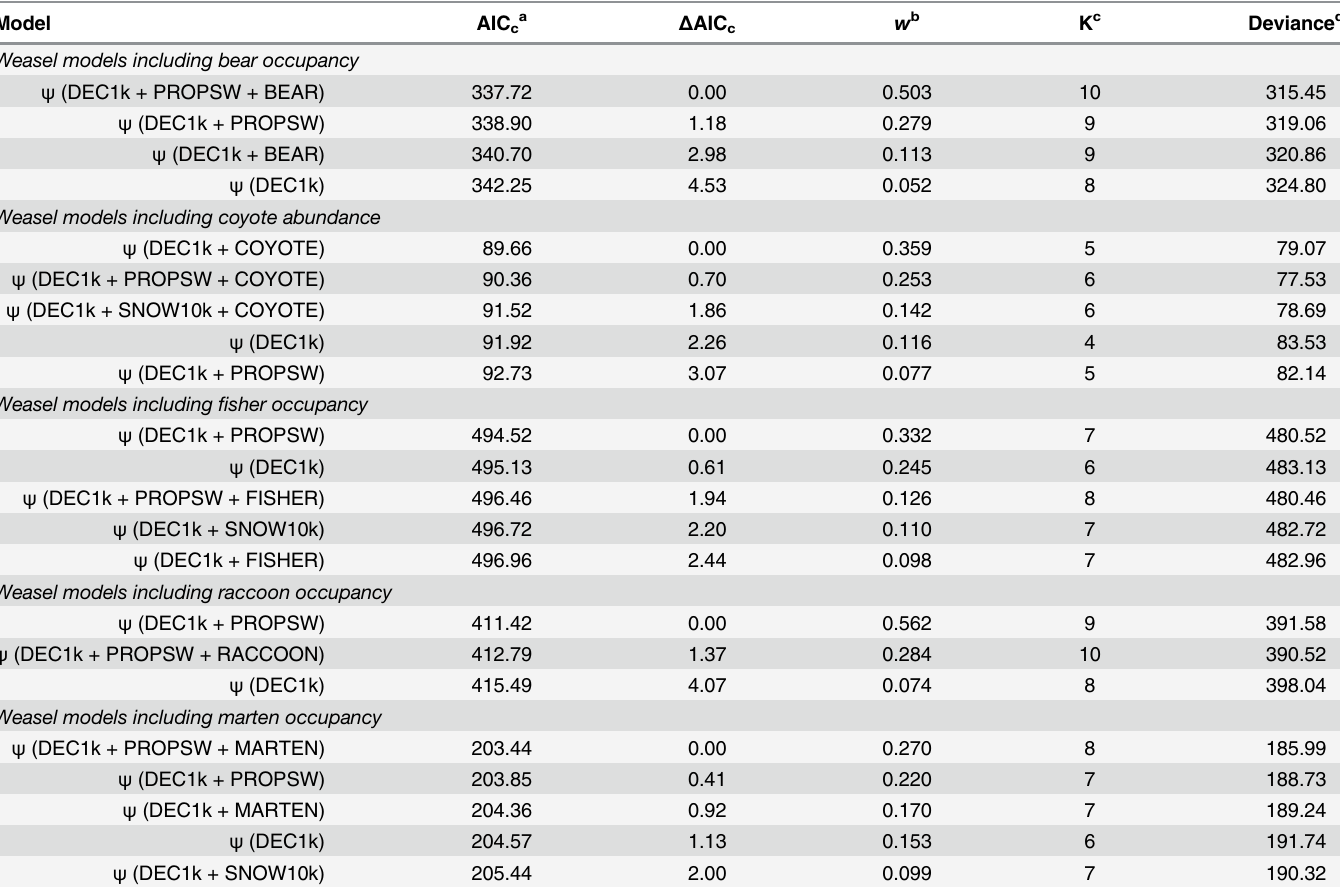
Table 5. Weasel co-occurrence models. Co-occurrence model selection results in the 90% confidence set for Mustela spp with the inclusion of U . ameri- canus , C . latrans , M . pennanti , P . lotor , and M . americana . We fit encounter history data from surveys at 54 sites in Adirondack Mountains, New York, USA to each candidate model set. Co-occurrence models were fit using important detection parameters and estimated occupancy, except C . latrans models which were fit using estimated abundance. See S1 Table for habitat variable descriptions.